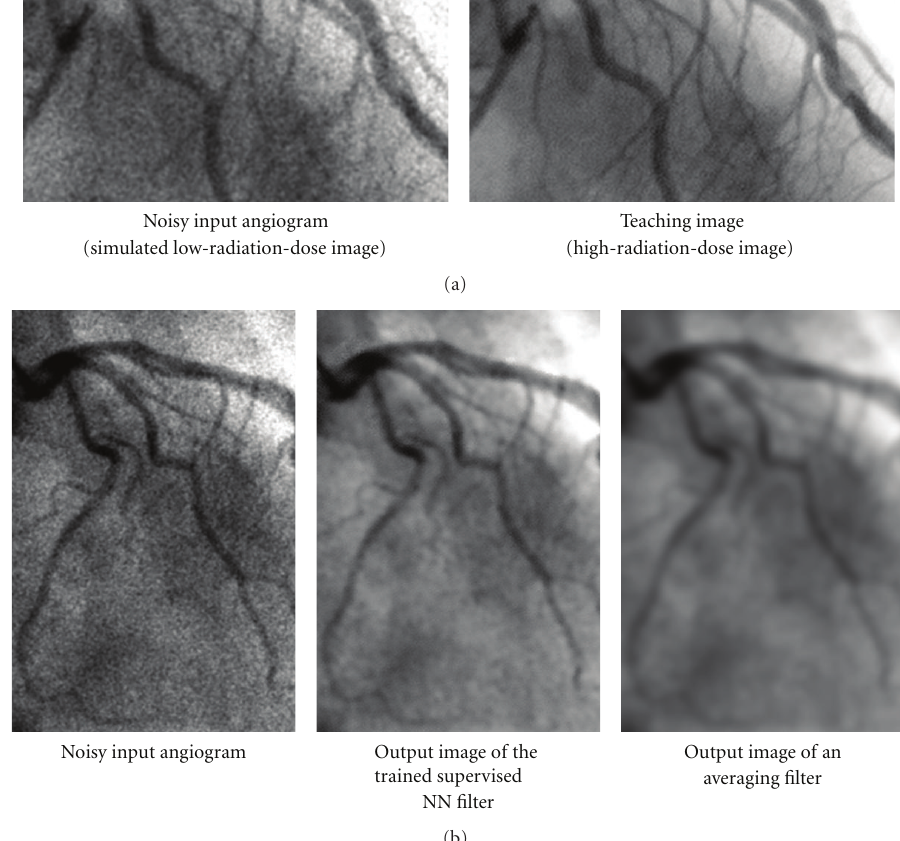
Figure 6: Reduction of quantum noise in angiograms by using a supervised NN filter called a “neural filter.” (a) Images used for training of the neural filter. (b) Result of an application of the trained neural filter to a nontraining image and a comparison result with an averaging